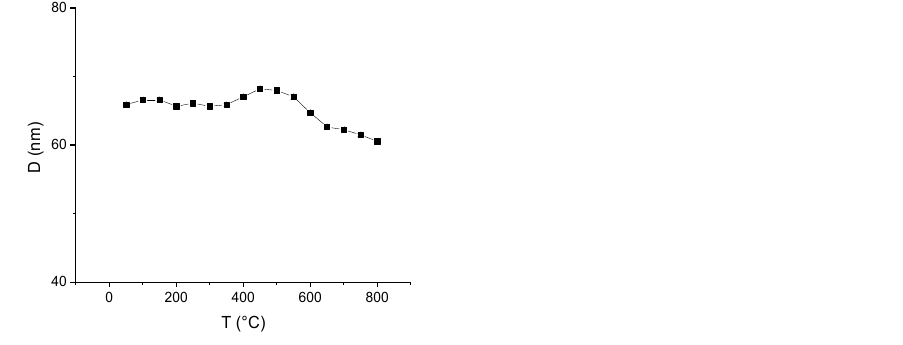
Figure 4. Average crystallite size of Mn 52 Al 46 C 2 sample vs. temperature of the measurement.